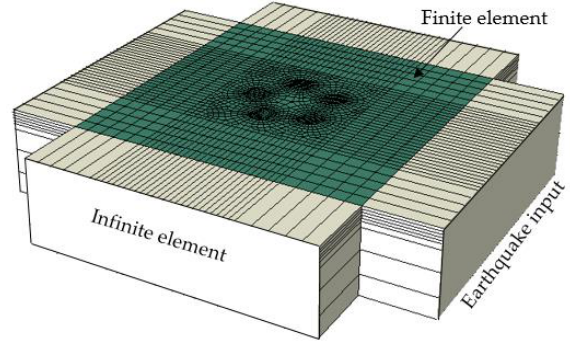
Figure 11. Illustration of soil.